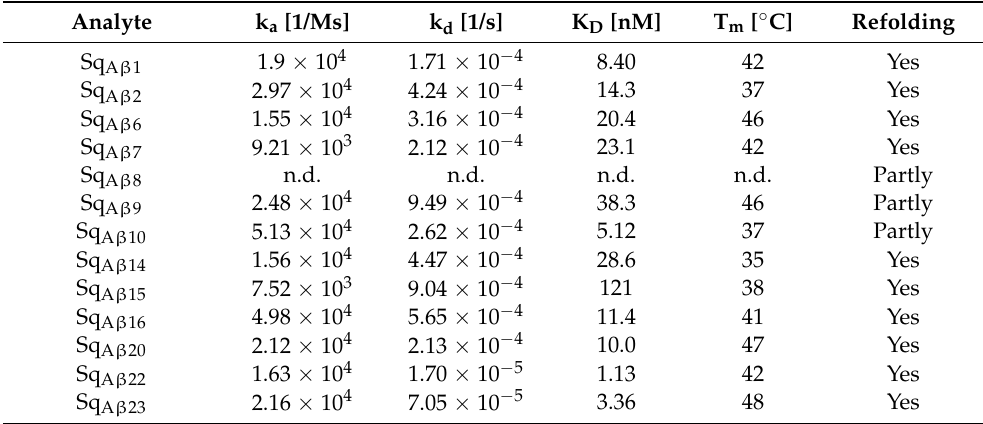
Table 1. Affinity data from SPR data fittings, thermal melting points (T m ) as well as refolding capabilities as assessed by CD.